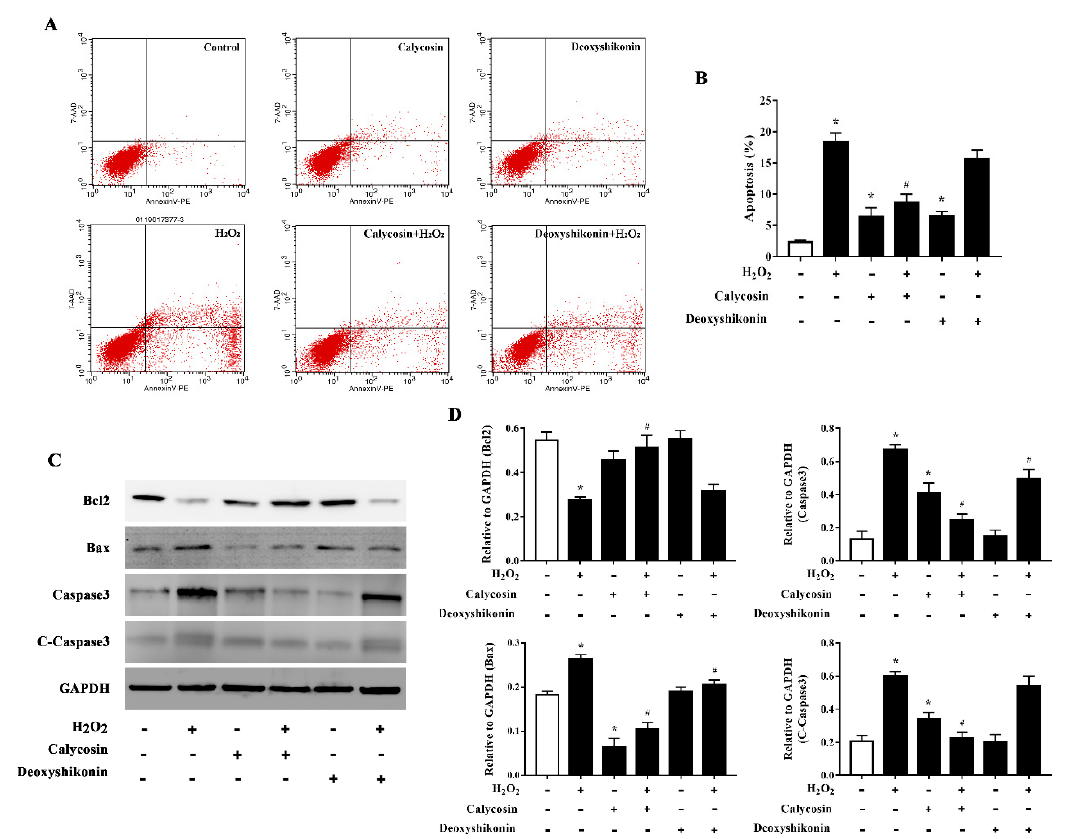
Figure 6. Effects of the hit compounds on H 2 O 2 -induced apoptosis in IPEC-J2 cells. IPEC-J2 cells were pretreated, and not pretreated, with calycosin or deoxyshikonin for 24 h, then with 1000 µ M H 2 O 2 for 4 h. Nontreated cells served as a control. ( A ) Flow-cytometric analysis of apoptotic cells. ( B ) Quantification of apoptotic cells based on flow cytometry data. ( C ) Western blots analysis of Bcl-2, Bax, caspase-3, and cleaved caspase-3 expression. ( D ) Quantitative analysis of apoptosis-related protein levels. Data represent the mean ± SEM of three independent experiments. Differences between two groups were determined using Student’s t -tests. * p < 0.05 vs. nontreated control cells; # p < 0.05 vs. H 2 O 2 -treated cells.